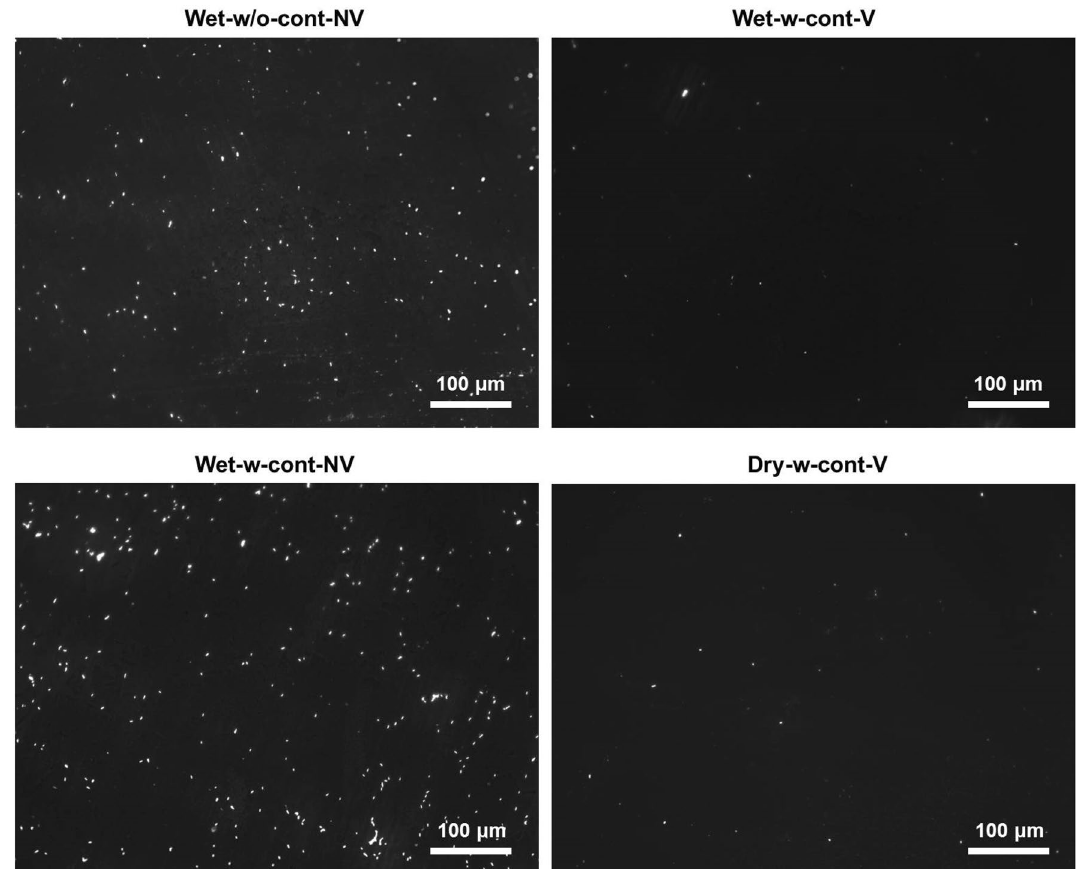
Figure 1. Representative fluorescence micrographs of P. fluorescens deposited on the surfaces of plastic containers and a thin polyimide film for a case of Wet-w/o-cont-NV after removing media. Four different sampling protocols were used in the EPC (− 5 kV) with a sampling medium of 1 × phosphate buffered saline: Wet-w-cont-NV (Wet sampling with a container, but no vortexing after the sampling), Wet-w-cont-V (Wet sampling with a container and subsequent vortexing after the sampling), Wet-w/o-cont-NV (Wet sampling on a polyimide film of the EPC electrode with no vortexing afterwards), and Dry-w-cont-V (Dry sampling with a container and subsequent vortexing after buffer addition). A great number of bacterial cells were attached to the surfaces when no vortexing was applied after electrostatic sampling (Wet-w/o-cont-NV and